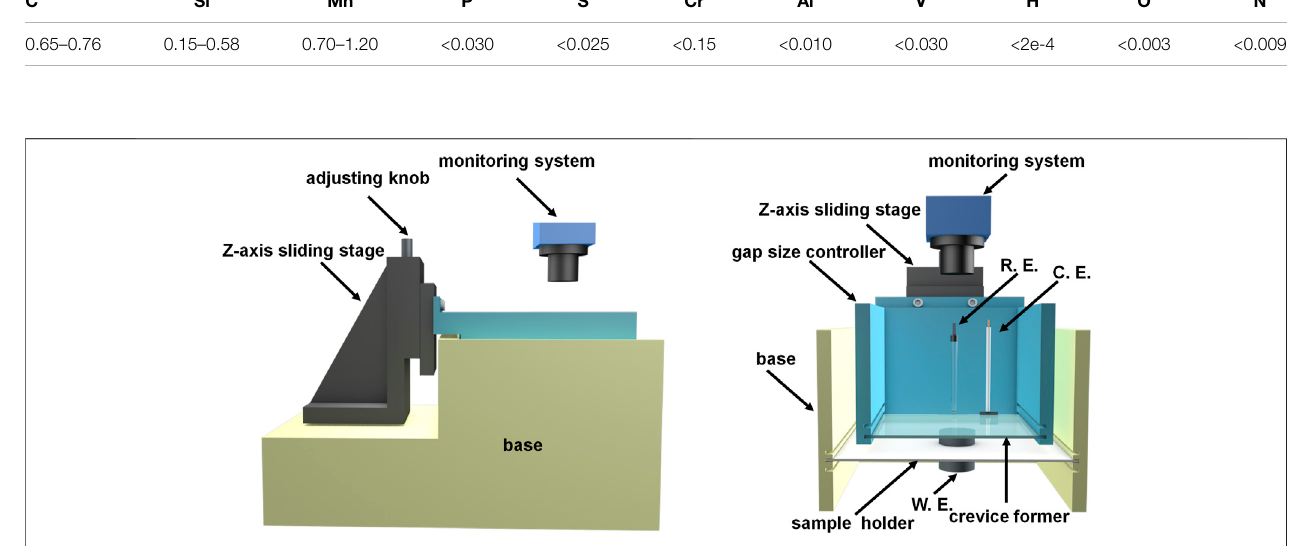
FIGURE 1 | Schematic diagram of the self-designed in situ monitoring